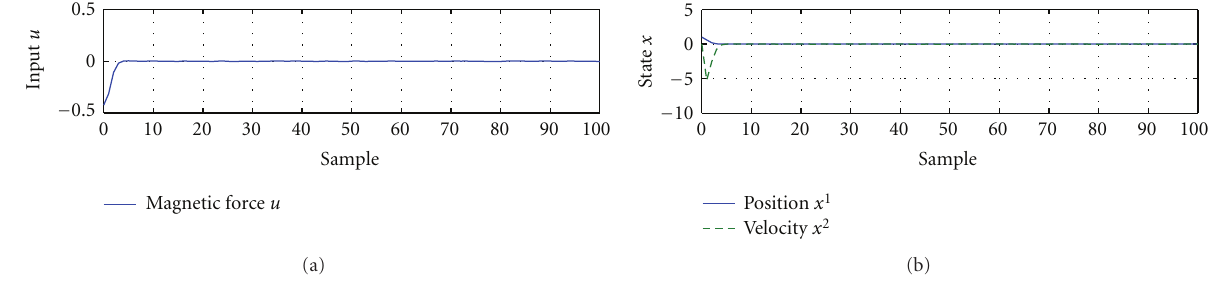
Figure 3: Closed-loop response of the solenoid system with γ 2 =